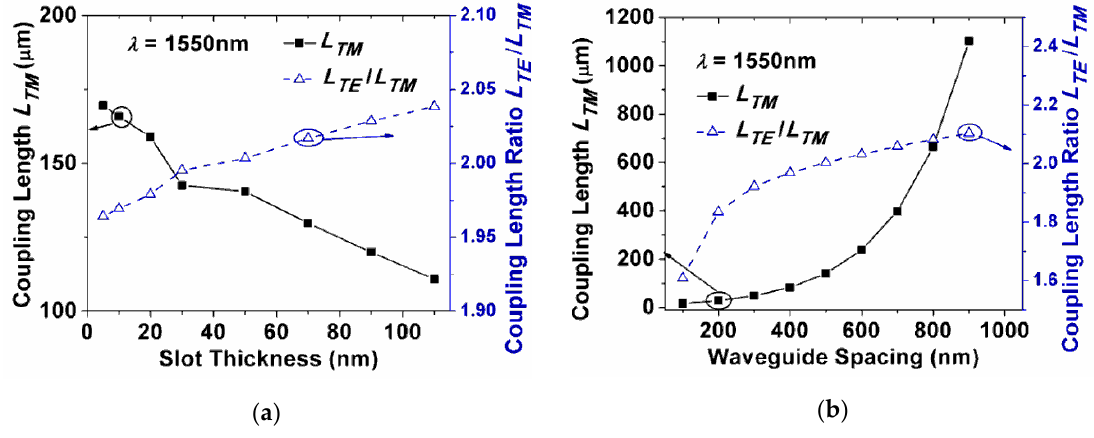
Figure 5. Coupling length of the quasi-TM mode and the coupling length ratio as a function of ( a ) the slot thickness H s ( d = 500 nm); and ( b ) the waveguide spacing d ( H s = 50 nm).